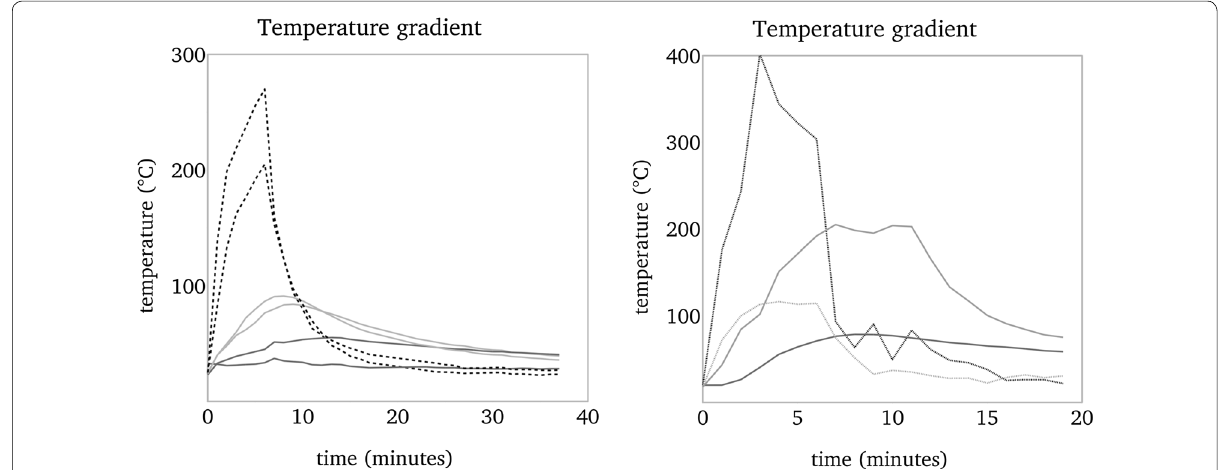
Fig. 4 Example of temperature gradients of A. digitata , left, and A. gregorii , right. Curves are smoothed, average temperature per 1 min. Left: Temperature gradient of 6 tc’s. Each 2 black dotted, light grey and dark grey lines are temperatures outside downwards, inside the shell downwards and in the centre. Heat exposure 06:25. Record time 37 min. Right: temperature gradient of 4 tc’s. Black dotted, light grey and dark grey lines are temperatures outside downwards, inside the shell downwards and in the centre. Grey dotted line is outside sidewards. Heat exposure 6 min. Record